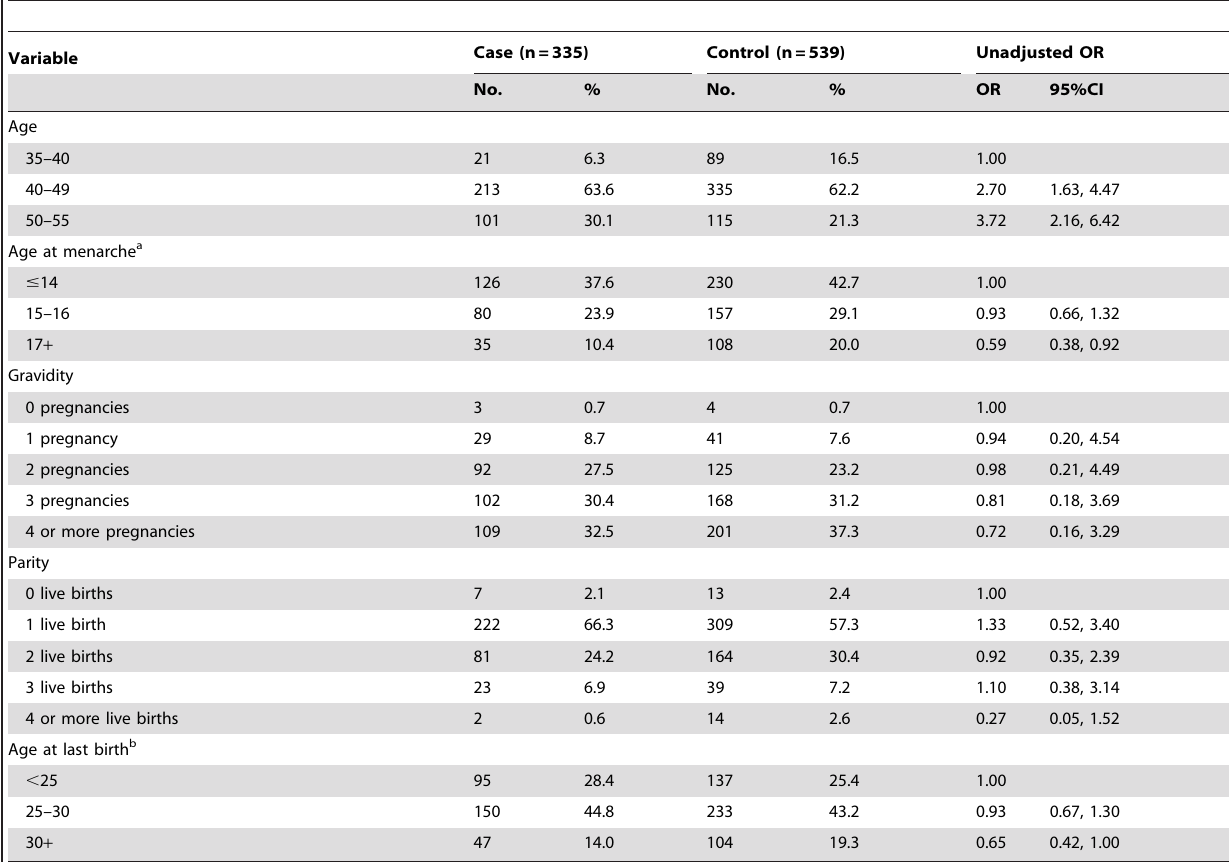
Table 1. Characteristics of cases with uterine fibroids and controls and unadjusted odds ratios for uterine fibroids according to selected